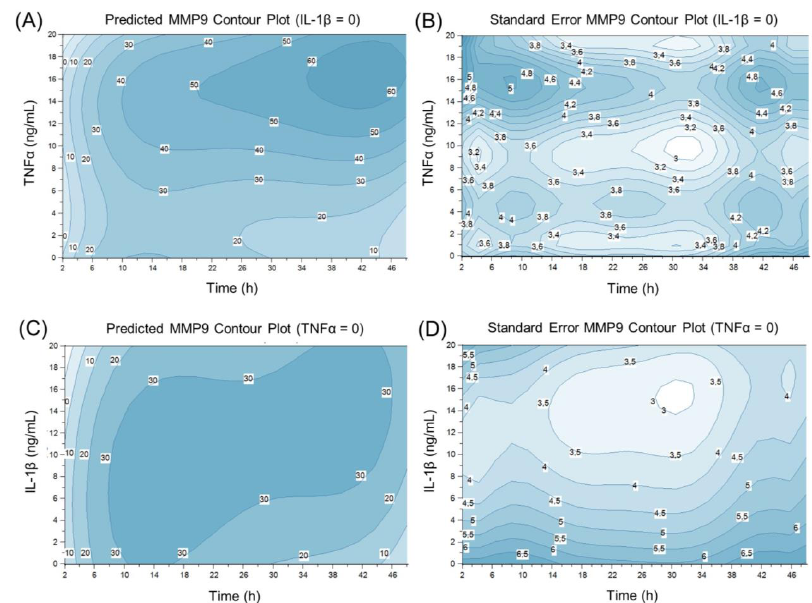
Figure 7. Contour plots of predicted MMP9 expression and standard error at single TNF α ( A , B ) or IL-1 β ( C , D ) induction over time.